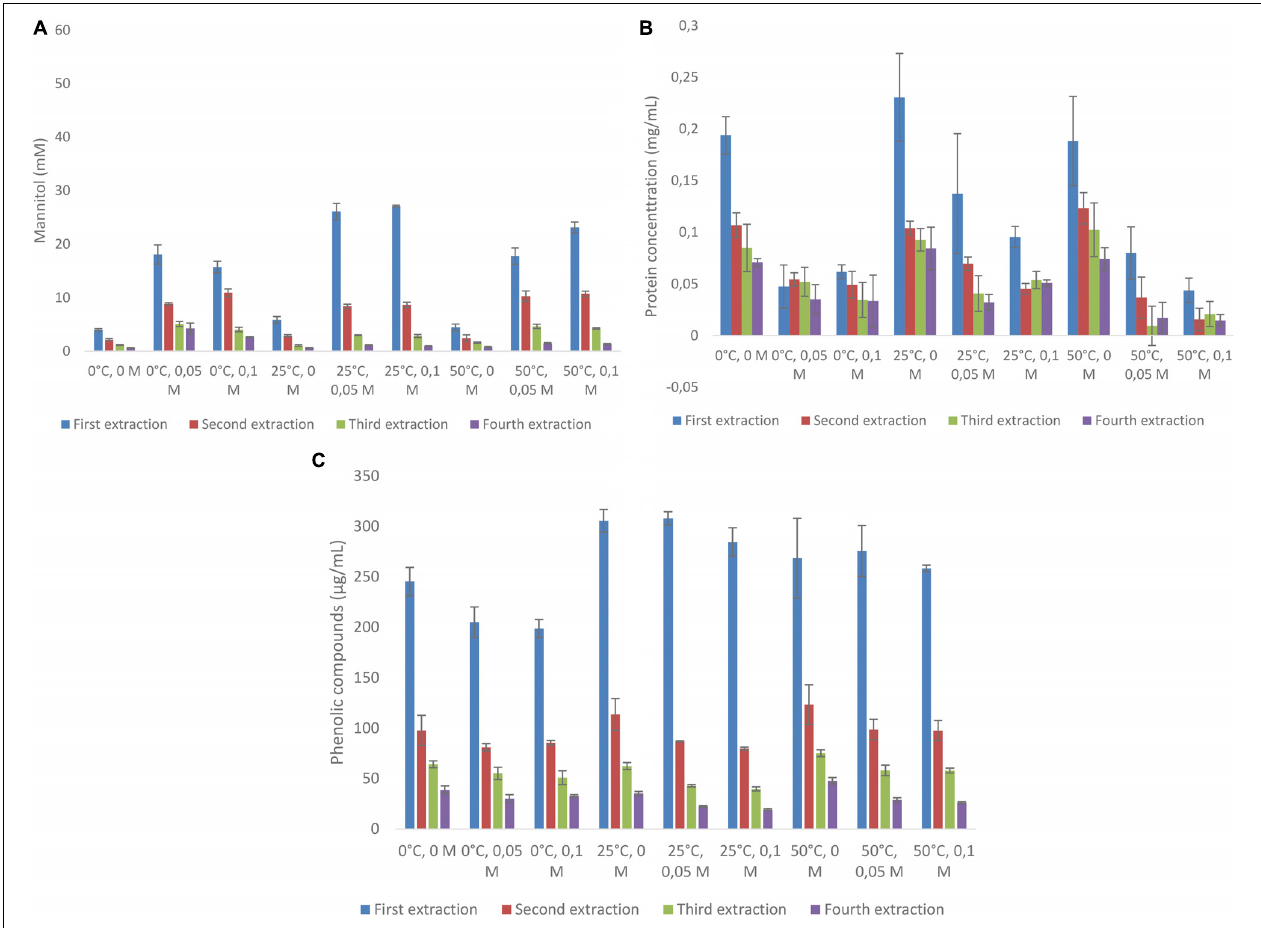
FIGURE 1 | Sequential solid-liquid extraction of mannitol from Ascophyllum nodosum at various temperature and HCl concentrations. (A) mannitol concentration, (B) protein concentration, (C) total phenolic compounds as gallic acid equivalent.